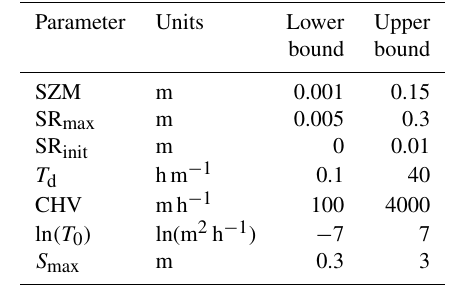
Table 2. Parameter